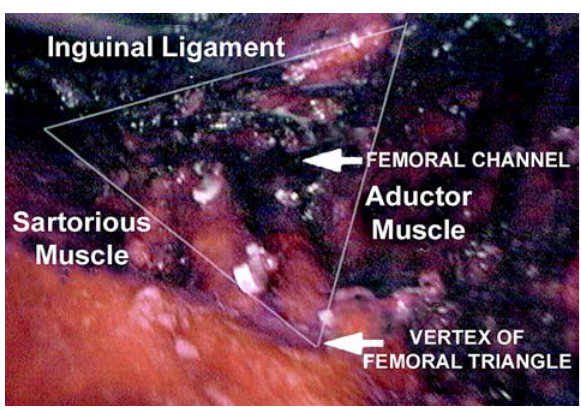
Figure 6 – Endoscopic view at the end of the lymph node dissection. The limits of the lymphadenectomy are viewed and all the lymphatic tissue was removed.